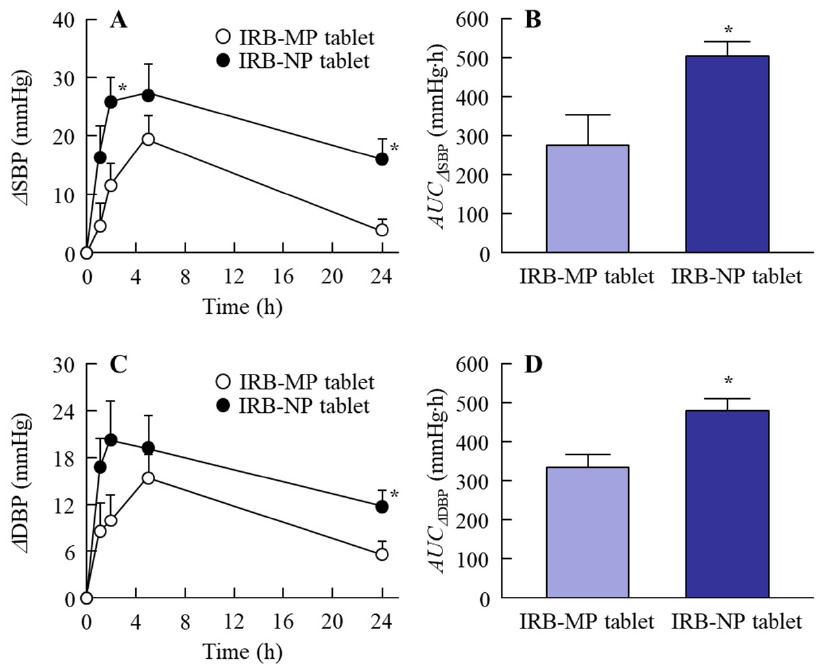
Figure 8. BP and DBP in the SHR-SP rats orally administered the IRB-NP tablet (Rp.8) shown in Table 1. ( A , B ) ∆ SBP profile ( A ) and AUC ∆ SBP ( B ) in the SHR-SP rats orally administered the IRB-NP tablet. ( C , D ) ∆ DBP profile ( C ) and AUC ∆ DBP ( D ) in the SHR-SP rats orally administered the IRB-NP tablet. n = 5–7. * p < 0.05 vs. IRB-MP tablet for each category. The BP-reducing effect of the IRB-NP